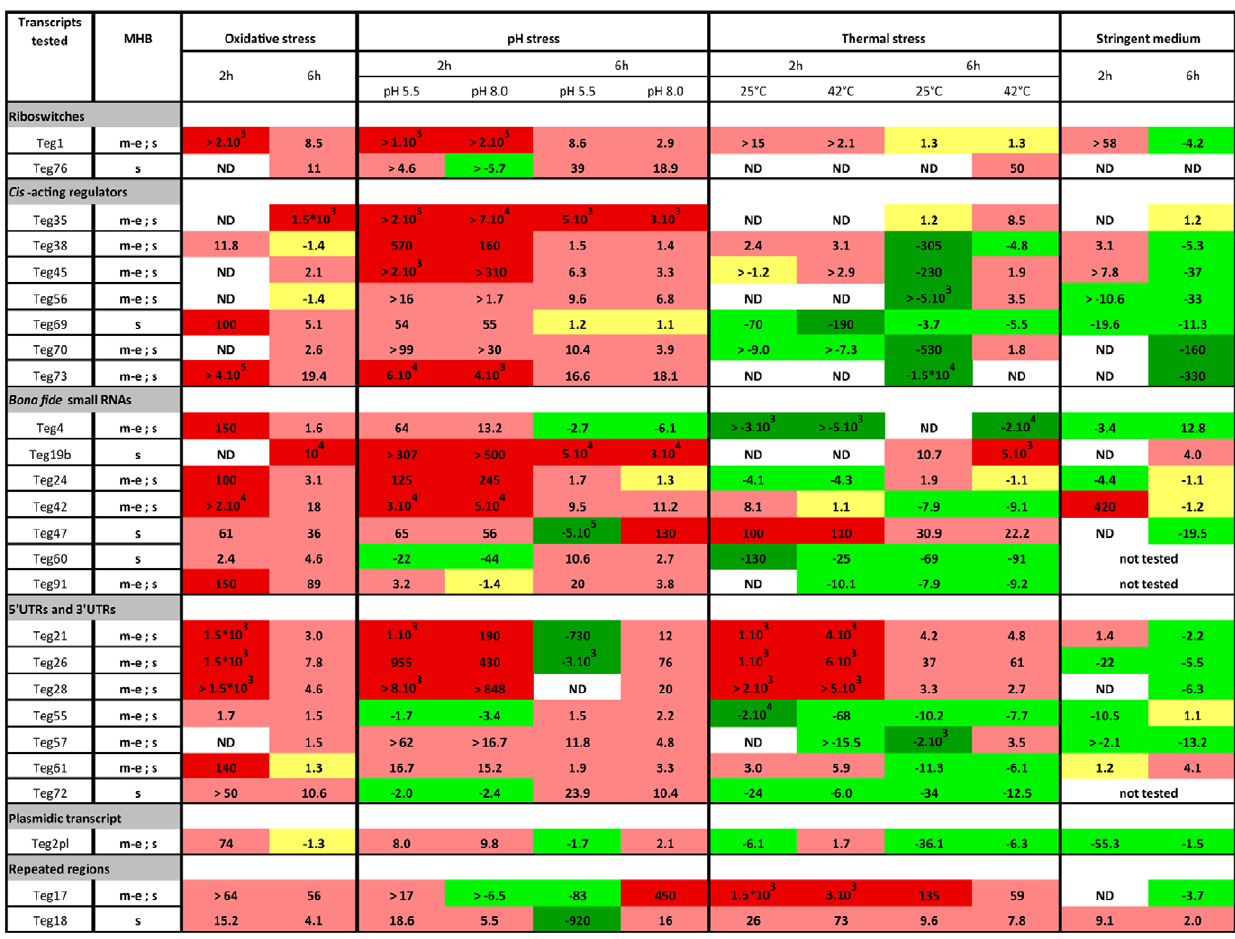
Figure 5. Temporal expression of selected transcripts in rich medium and under various stress conditions. Analysis of the expression of 26 selected transcripts by RT-qPCR in rich medium (MHB) and under four stress conditions: oxidative stress, pH stress, heat and cold shocks, changing of carbon source with stringent medium. The data have been normalized against the hu reference gene. We used m-e for mid-exponential phase and s for stationary phase to map the kinetics observed in MHB. Transcript induction or repression has been expressed as fold change against the MHB reference condition. The color scale reflecting the intensity of expression changes: dark red : fold change . 100, light red : 1.3 , fold change , 100, yellow : 2 1.4 , fold change , 1.3, light green : 2 100 , fold change ,2 1.4, and dark green : fold change .2 100. ND corresponds to ‘‘Not Determined’’ value, whenever no expression of tested RNA was visualized before the 40 PCR cycles. The symbol ‘‘ . ’’ is applied whenever signal was detected for the target but no in the MHB reference. Note that Teg17 and Teg18 are found in multicopy. The expression observed in RT-qPCR is therefore the addition of transcription level from different coding sequences or belongs to another genomic location.